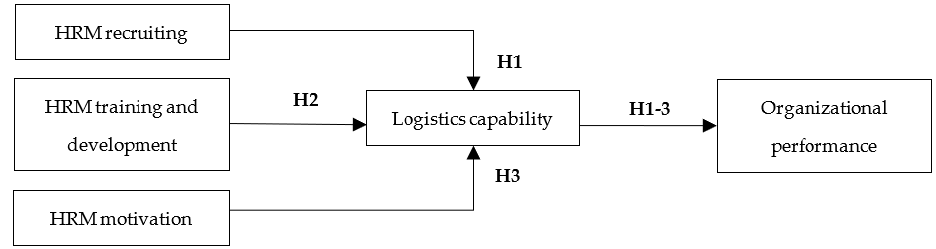
Figure 1. The research